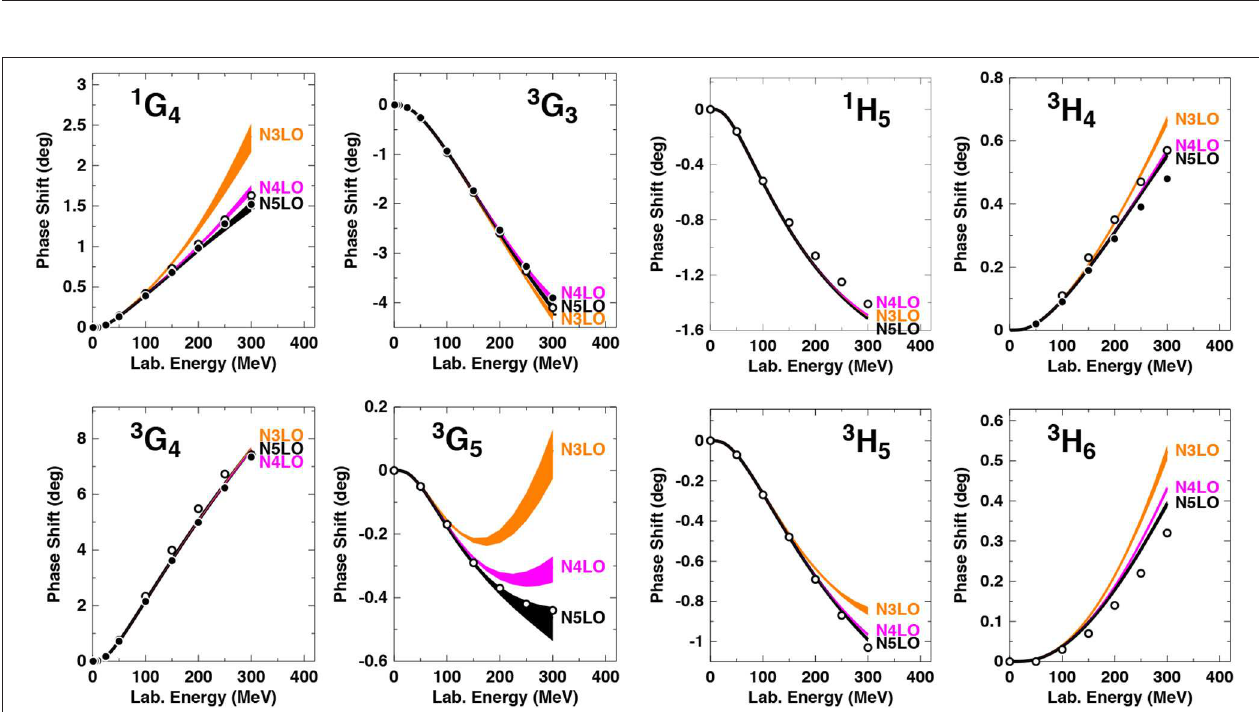
FIGURE 13 | Phase-shifts of np scattering in G and H waves at various orders as denoted. The shaded bands show the variations of the predictions when the SFR cut-off ˜ 3 is changed over the range 700 to 900 MeV. Empirical phase-shifts as in Figure 12 . Reprinted figure with permission from Entem et al. [48], copyright (2015) by the American Physical Society.